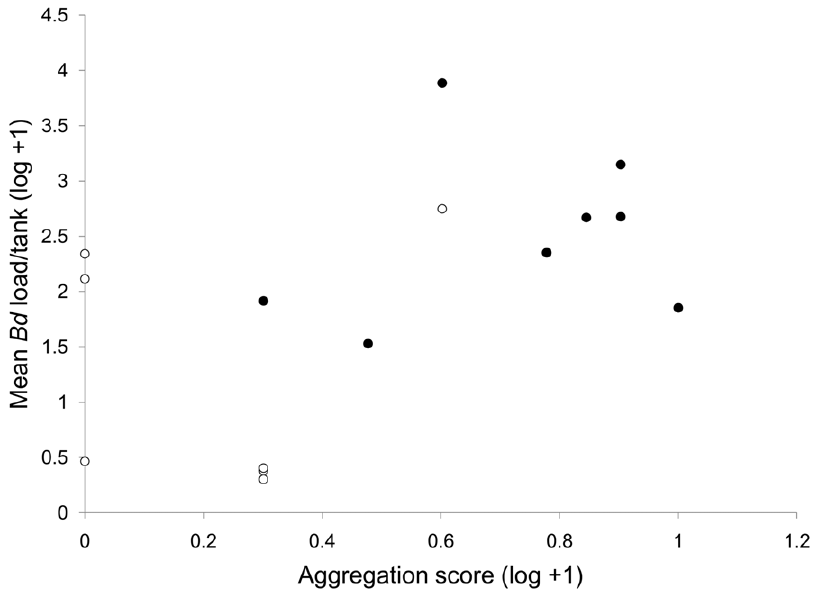
Figure 2. Relationship between mean Batrachochytriumdendrobatidis ( Bd ) load and proportion of tadpoles aggregating. Bd load (log + 1) was averaged across all infected tadpoles and aggregation score (log + 1) represents the proportion of tadpoles aggregating within a single replicate. Closed circles represent A. fowleri tadpoles; open circles represent H. versicolor tadpoles.